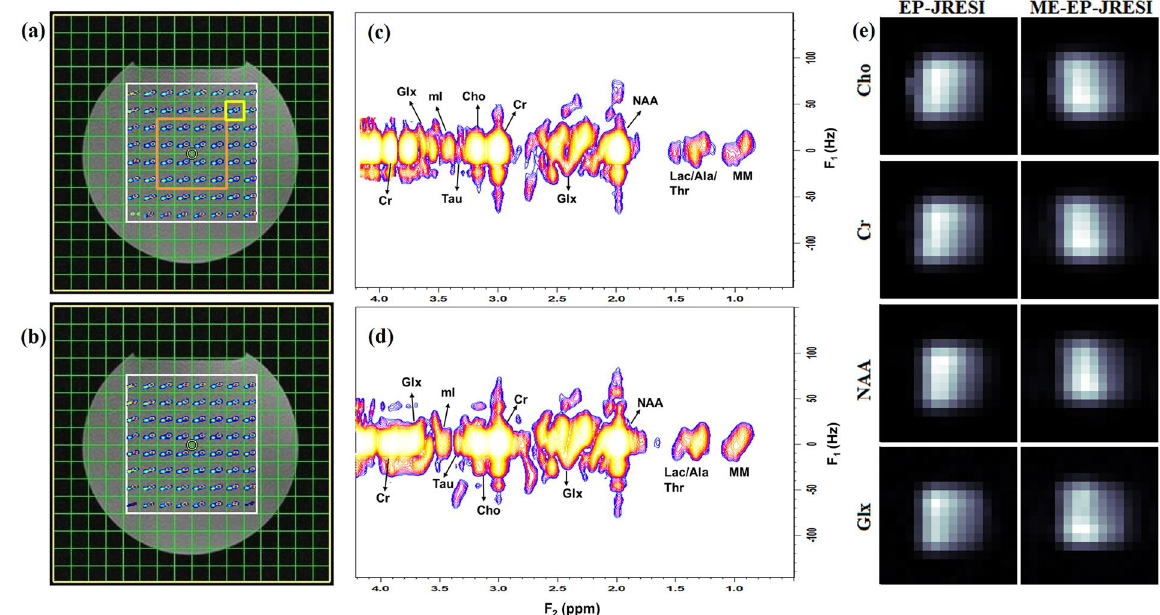
Figure 3. The multi-voxel spatial distribution of 2D peaks of Cr/Cho (F 2 = 2.9–3.3 ppm, F 1 = ± 15 Hz) overlaid on top of the T 1 -weighted axial MRI from ( a ) EP-JRESI scan, ( b ) ME-EP-JRESI scan; selected 2D J -resolved spectra ( c ) from EP-JRESI, ( d ) ME-EP-JRESI, extracted from the voxel in yellow box in ( a ); and ( e ) comparison of metabolite maps as measured by peak area integration obtained by summing the peak area over the range of the metabolites. The orange box in ( a ) shows the 4 × 4 voxel considered for Table 1. The white box in ( a , b ) indicates the PRESS localization for respective data.